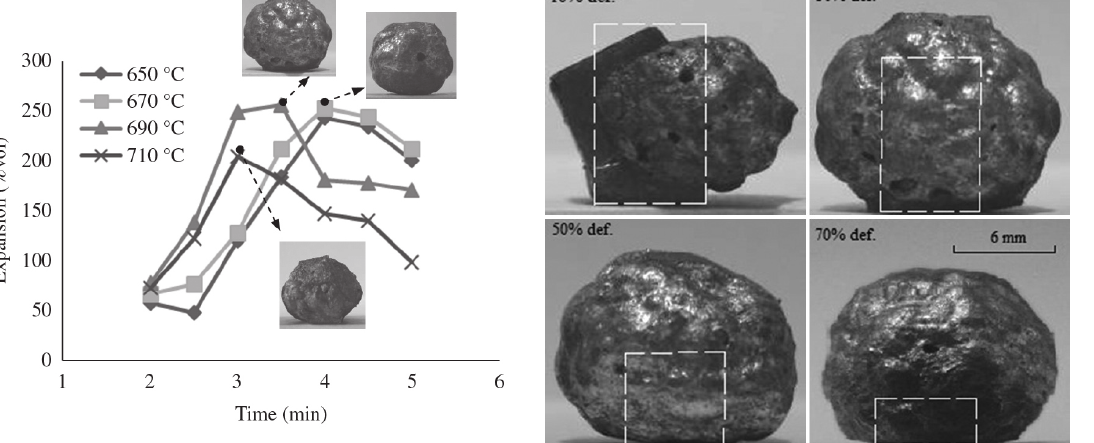
Figure 4. Expansion rates of 30% deformed samples at various foaming temperatures.